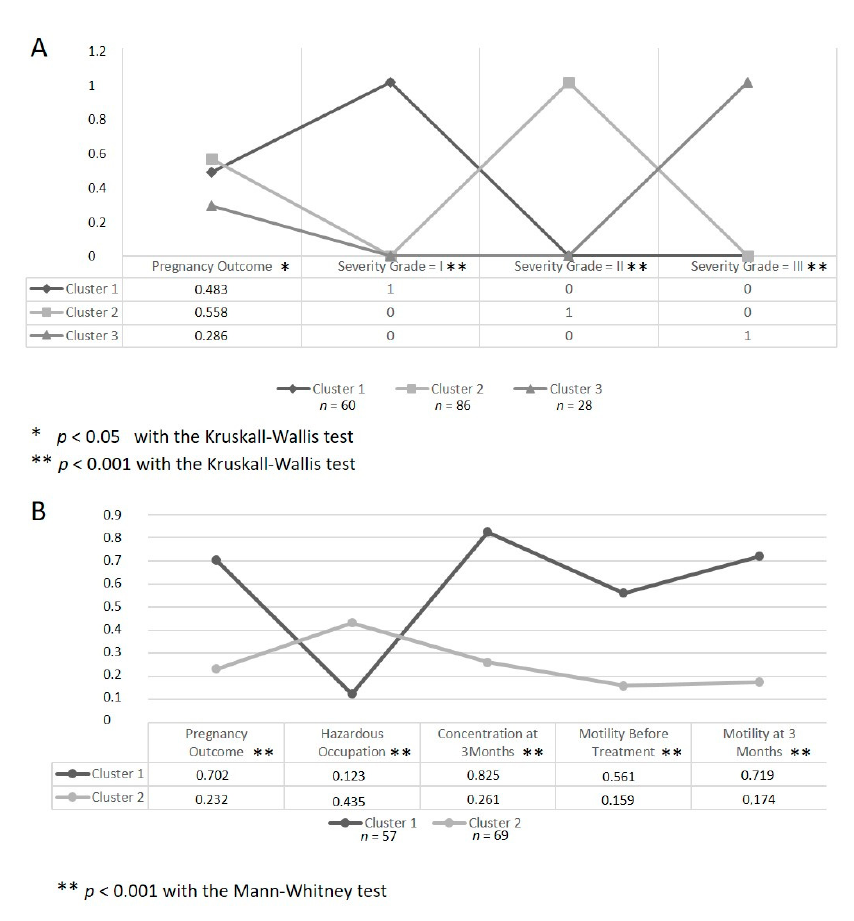
Figure 4. Data patterns related with the pregnancy outcome: ( A ) implication of the varicocele severity grade; ( B ) implication of a putative hazardous occupation and the normality of sperm parameter